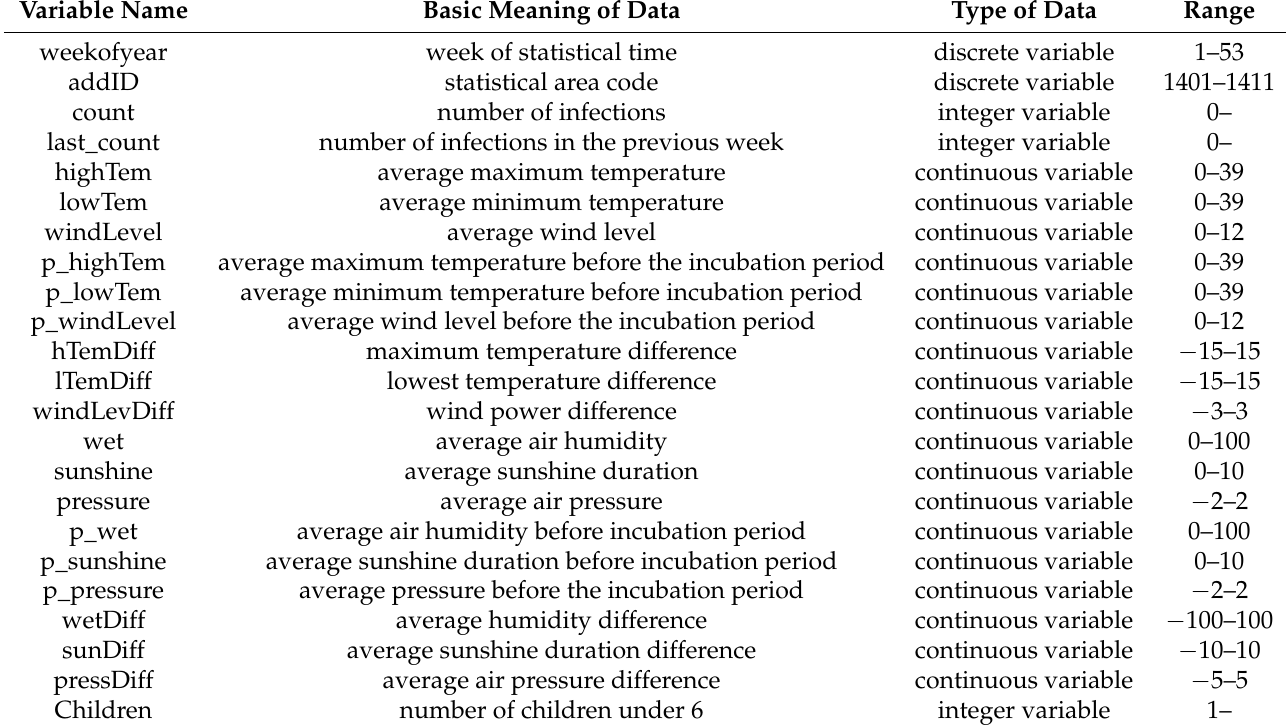
Table 1. HFMD epidemiological research data